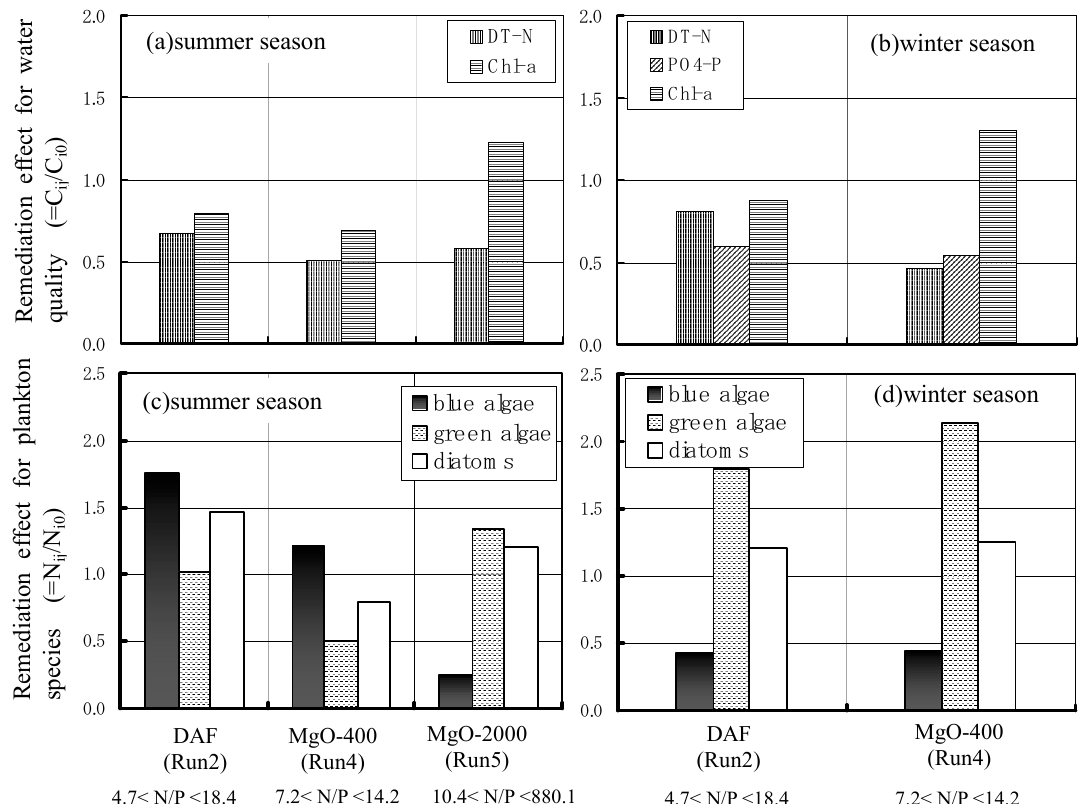
FIGURE 6. Remediation effect for water quality and phytoplankton